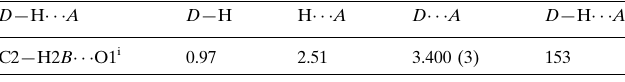
Hydrogen-bond geometry (A˚ , (cid:2)